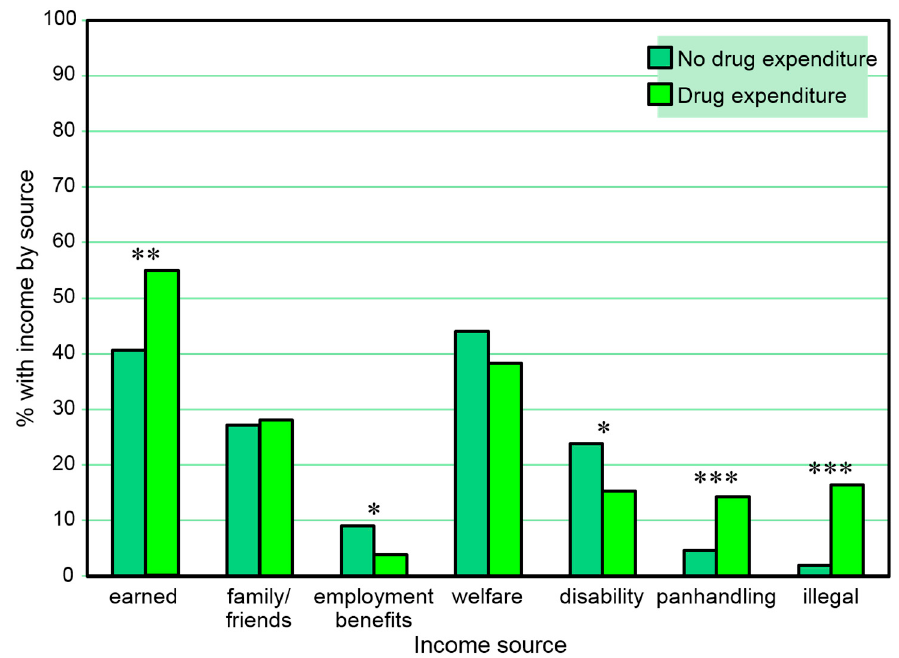
Figure 6. Proportions with 30-day income sources among those with and without 30-day drug expenditures in the same month. * p ≤ 0.05, ** p ≤ 0.01, *** p ≤ 0.001.